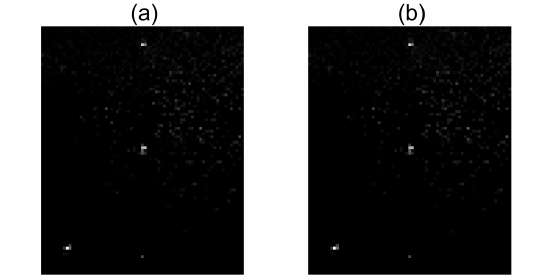
Figure 24. Real dataset—( a ) Reference image f ∗ obtained by IRLS after 500 iterations; ( b ) Image ˆ f k obtained by IRLS after 30 iterations. API values are given in Table 3.